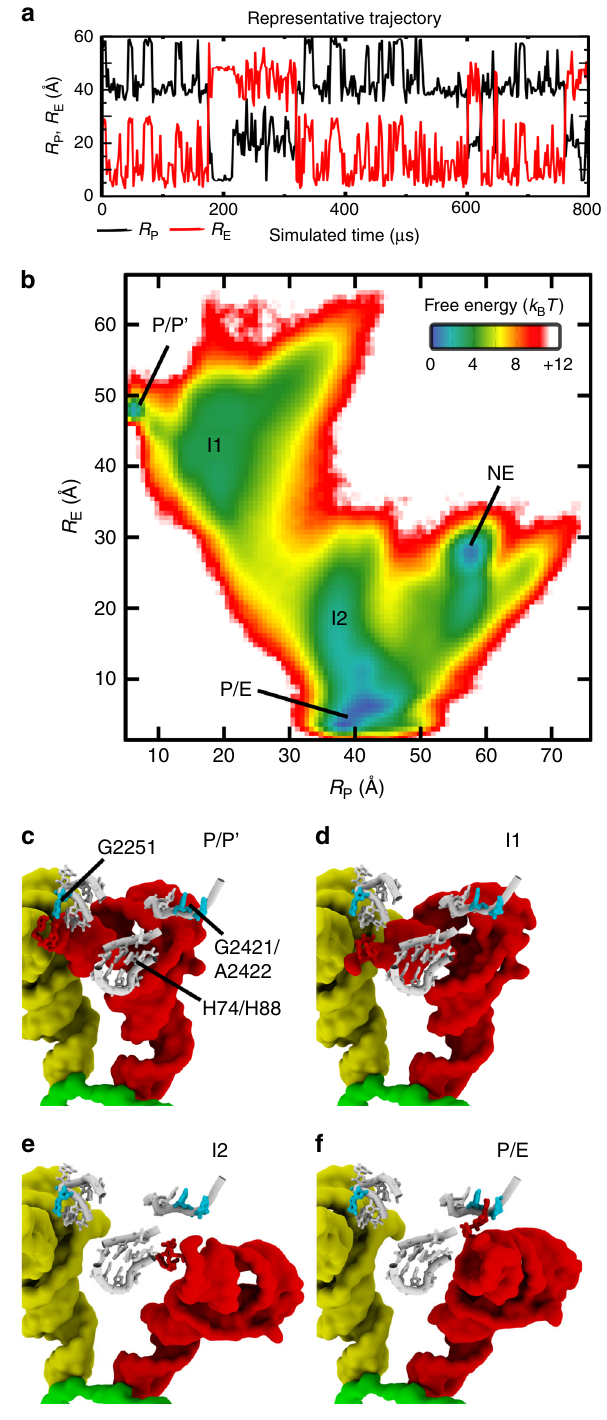
Fig. 2 Capturing sterically-induced intermediates during P/E-hybrid formation. a Using an all-atom structure-based model 42,43 of the